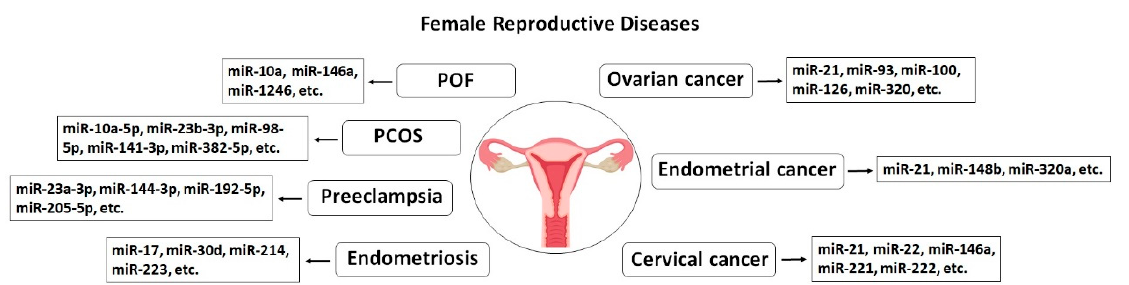
Figure 2. A summary of exosomal miRNAs reported in recent studies considering their role in the pathogenesis of the most noticeable female reproductive diseases. miR, miRNA, microRNA; POF; Premature Ovarian Failure, PCOS; Polycys- tic Ovary Syndrome.